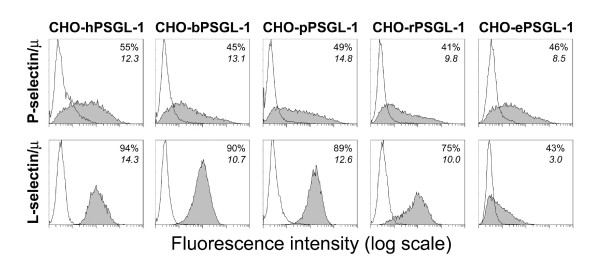
Human L- and P-selectin/μ chimera cross-react with CHO cells expressing mammalian homologues of PSGL-1. CHO cells, stably expressing similar levels of human C2GnT-I, FucT-VII and human (h), bovine (b), pig (p), rat (r) or equine (e) PSGL-1, were incubated with saturating concentrations of human P- or L-selectin/μ chimeras (filled histogram). Chimera binding was abrogated by 10 mM EDTA (open histogram). Human P- and L-selectin chimera did not bind (< 2%) to mock-transfected CHO cells (not shown). The percentage of positive cells and the mean fluorescence intensity are indicated in each histogram. Histograms are representative of 3–4 experiments.